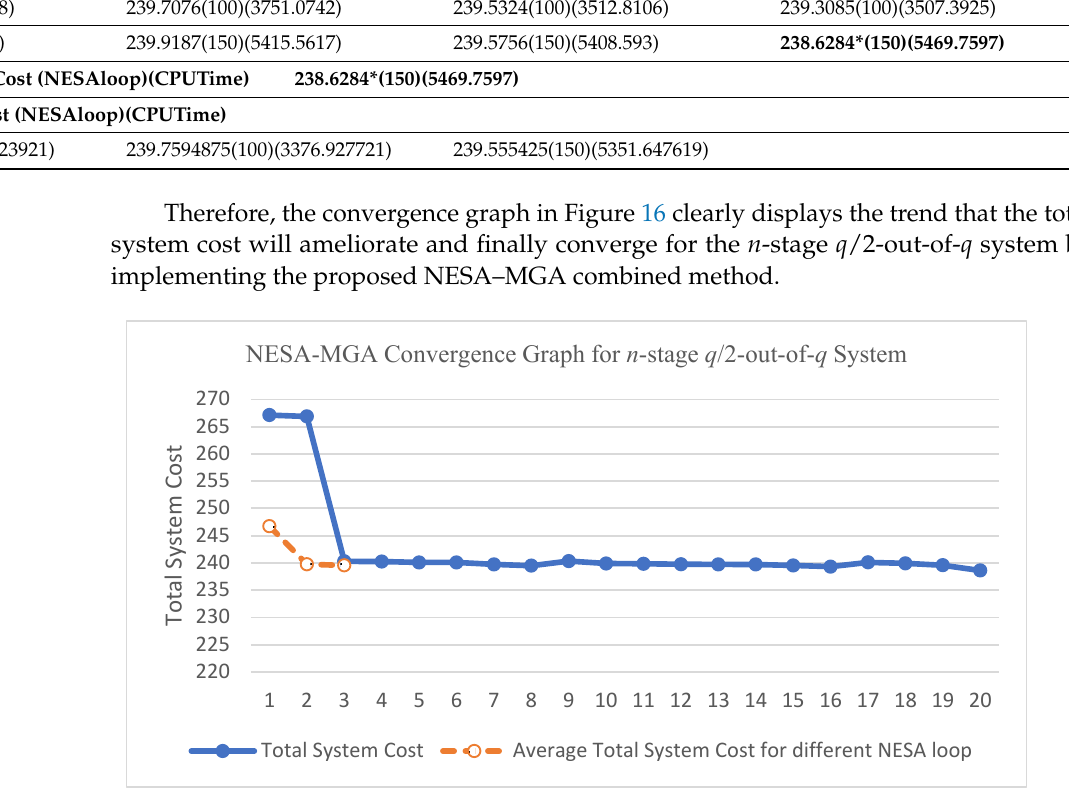
Figure 16. The convergence graph of the n -stage q /2-out-of- q system for the NESA–MGA com- bined method.